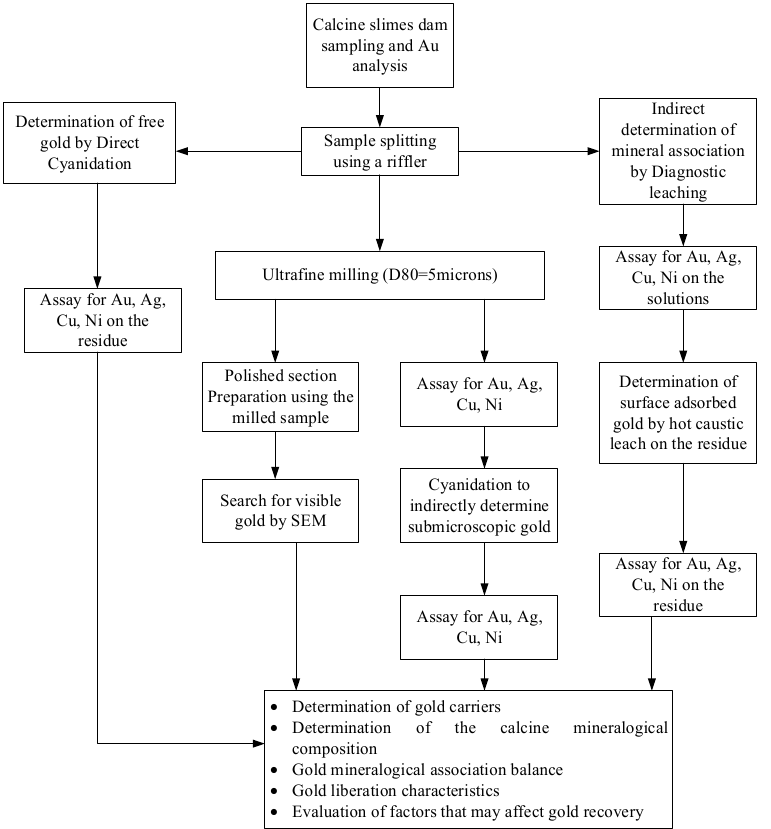
Figure 1. The procedure that was followed in this investigation.